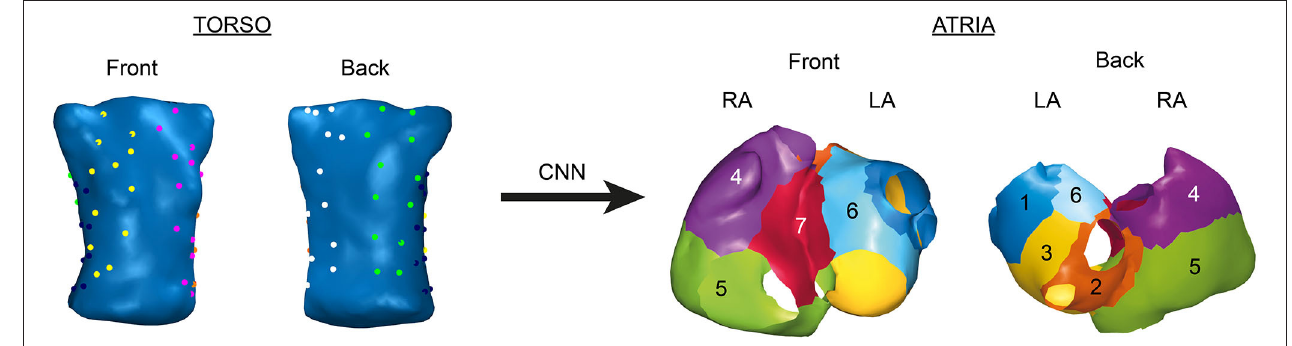
FIGURE 1 | Position of the electrodes for body surface potential mapping (BSPM, left) and regions in atria where AF drivers can be found